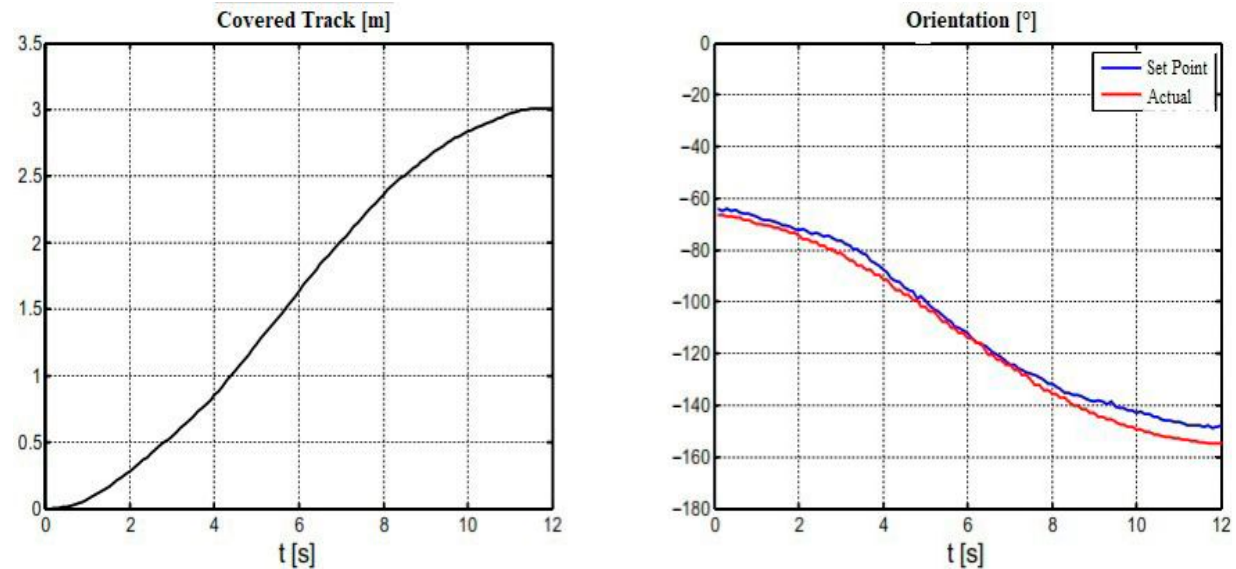
Figure 7. Target and actual value of the robot’s orientation.